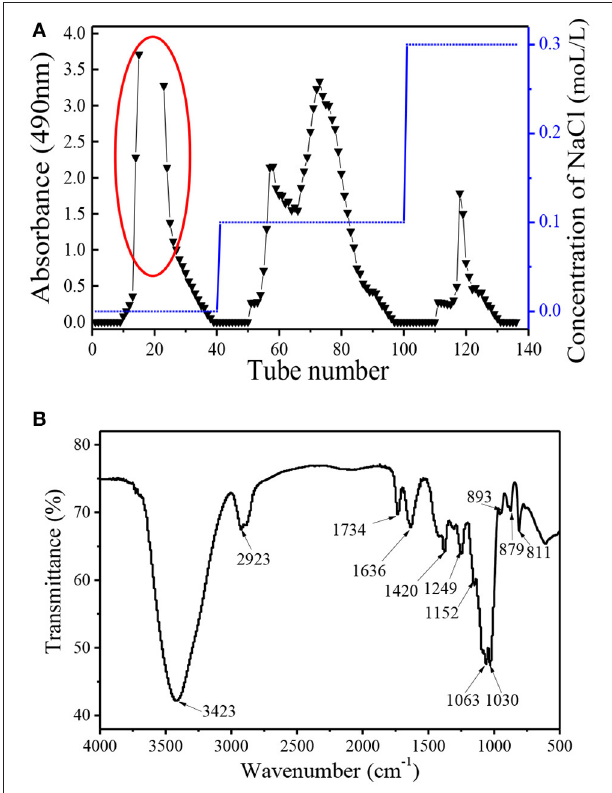
FIGURE 1 | Elution curve of DHPs-1 on DEAE-52 (A) ; FT-IR spectrum of DHPs-1 (B) .